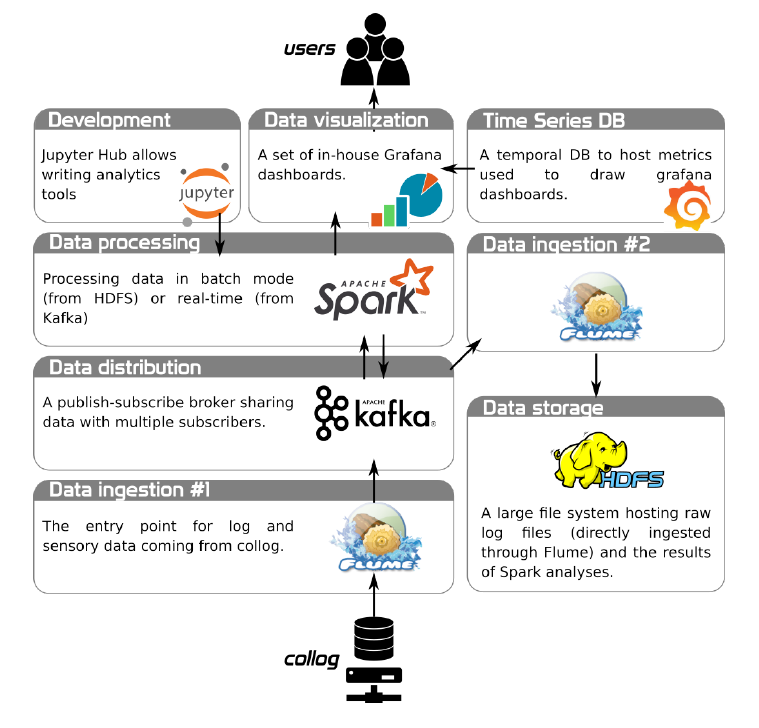
Figure 2. Detailed view of the Big Data